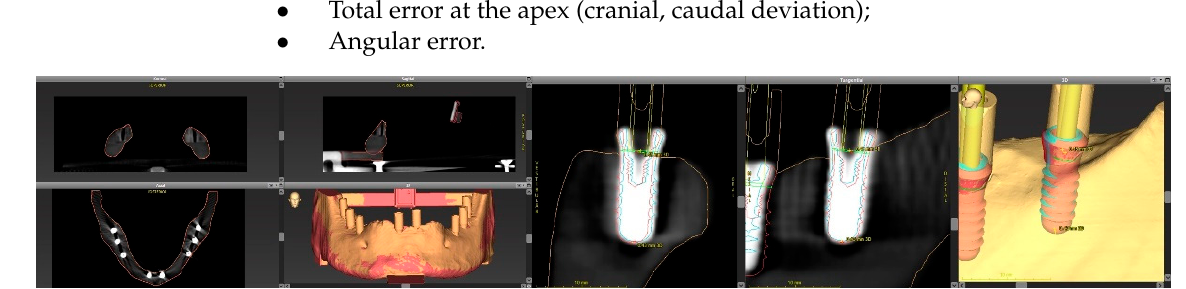
Figure 3. On the left side is a scanned and matched acrylic mandible of a student with inserted implants and screwed SmartPegs. On the right side, an inserted implant is compared with the master implant. The deviations from the master implant were calculated.